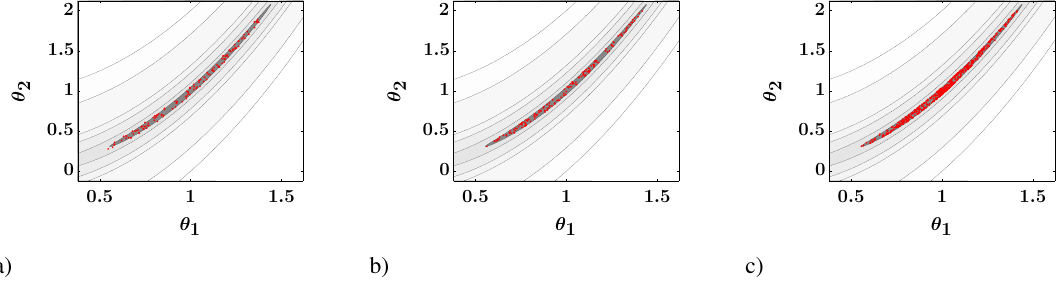
Fig. 6: A scatterplot of the ( θ 1 ,θ 2 ) samples of good parameter vectors generated using the iterative Monte Carlo approach in the original ROPE (a) , the modified version A-ROPE (b) and the PSO based PSO-GA u algorithm (c) . The dark grey region represent the true distribution of the good parameter vectors considering a tolerance of 0.2. Monte Carlo method from in both ROPE and A-ROPE, and the PSO-GA u algorithm in order to estimate a set of good parameter vectors within the given tolerance.